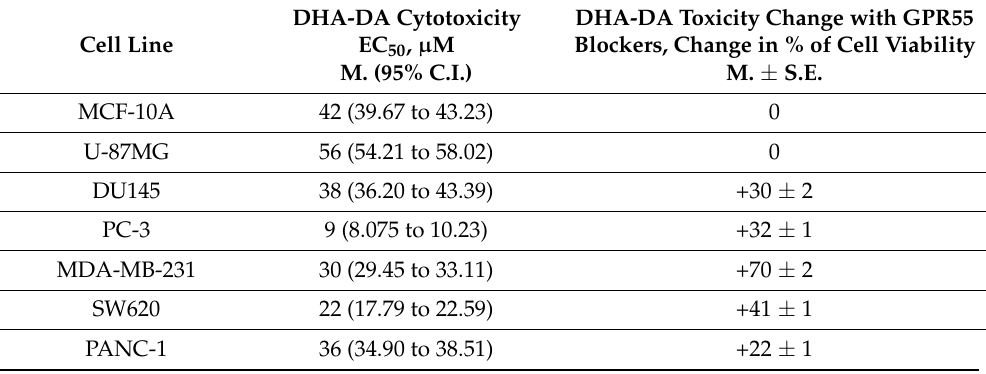
Figure 5. Cytotoxicity of N -docosahexaenoyl dopamine (DHA-DA) for the cell lines without (MCF-10A, U-87 MG) and with (all other lines) the GPR55 receptor. Incubation time 24 h, MTT assay, mean ± S.E., n = 3 experiments. ( A ) Dose-effect curves for the cell lines with GPR55. ( B ) The activity of DHA-DA (the concentration was chosen as EC 75 or EC 50 , cf. Table 3) with the addition of the GPR55 blockers CID16020046 (CID, 0.4 µM) and cannabidiol (CBD, 0.4 µM). The blockers did not affect cell viability at these concentrations. *, a statistically significant difference from the control without inhibitor for the appropriate cell line, **, a statistically significant difference from the DMSO control, ANOVA with the Tukey post-test, p ≤ 0.05. Table 3. N-docosahexaenoyl dopamine (DHA-DA) cytotoxicity for various cell lines correlates with the GPR55 blocker activity. Incubation time 24 h, MTT assay, EC 50 values (lower value means higher toxicity, mean with 95% confidence interval) and presence of blocker activity.